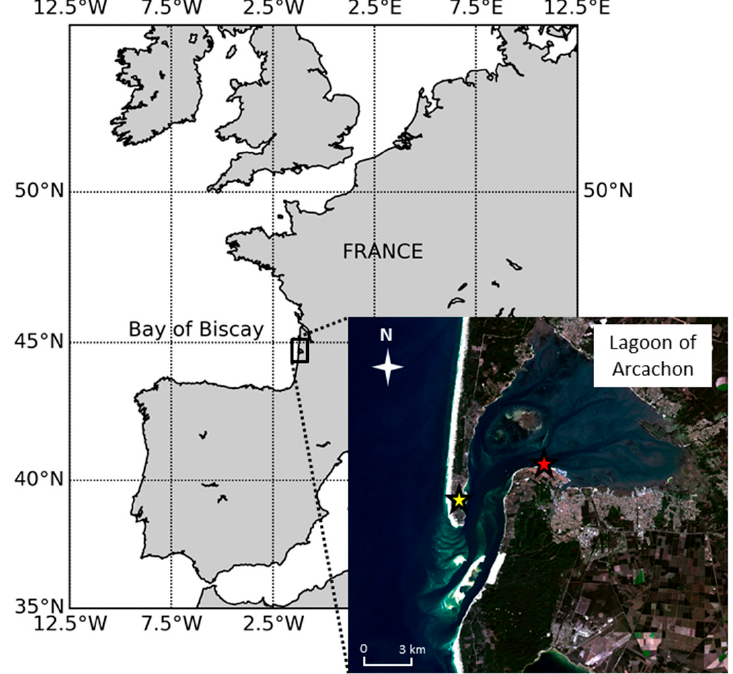
Figure 1. Landsat-8/Operational Land Imager (10-01-2014) image acquired over the Arcachon lagoon area (Southwest France), showing the location of the CIMEL sun photometer (red star) and meteorological (yellow star) stations.